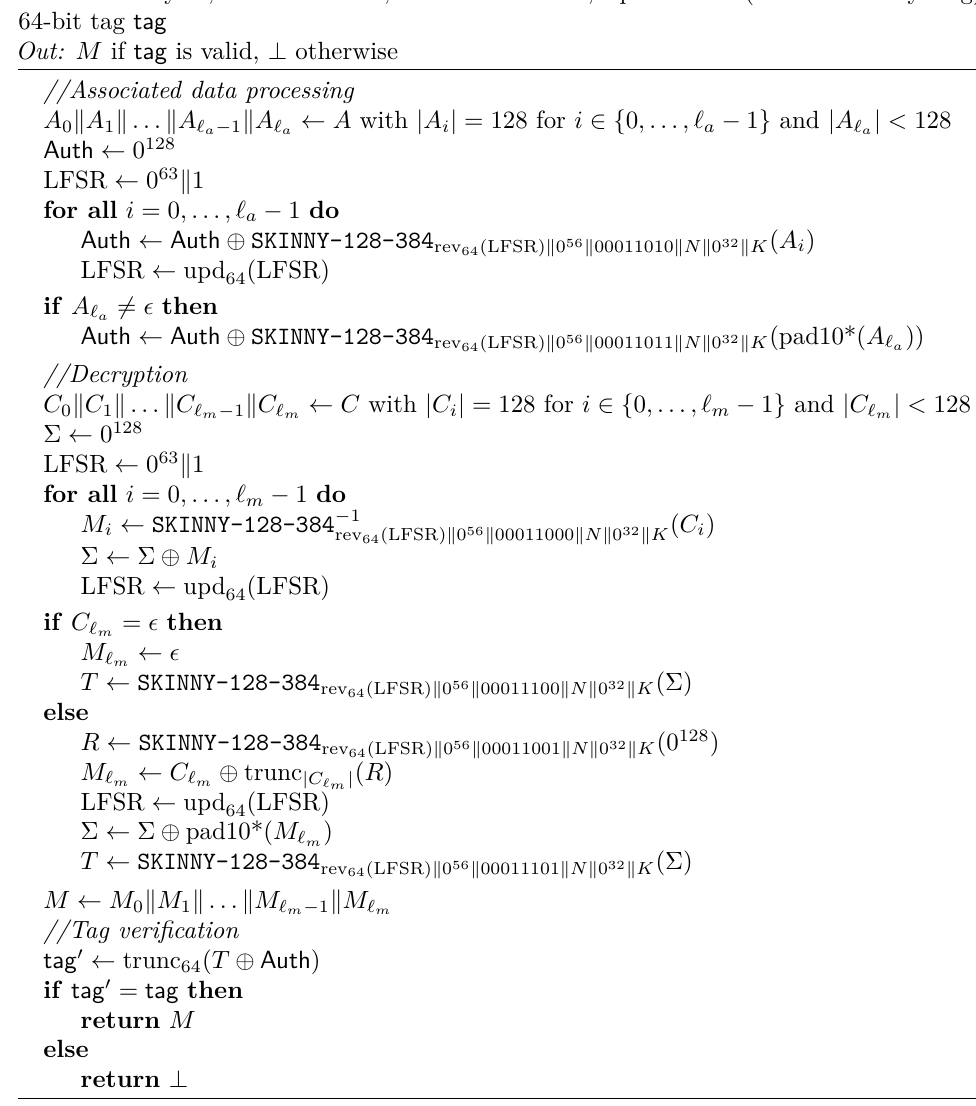
Algorithm 10 The decryption algorithm SKINNY - AEAD - M4 - Dec ( K, N, A, C, tag